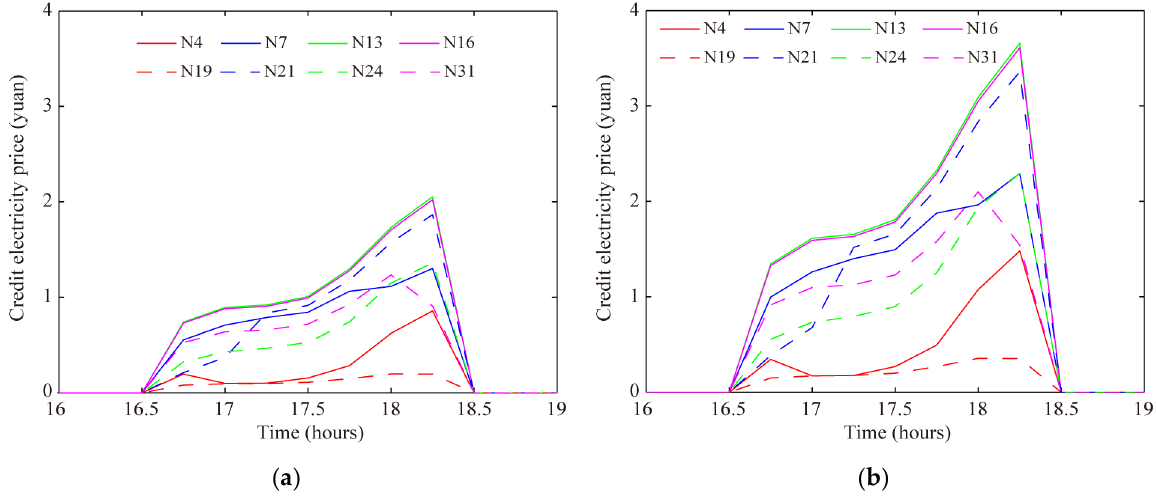
Figure 18. Credit electricity price under random fluctuation. ( a ) Random fluctuation A; ( b ) Random fluctuation B.